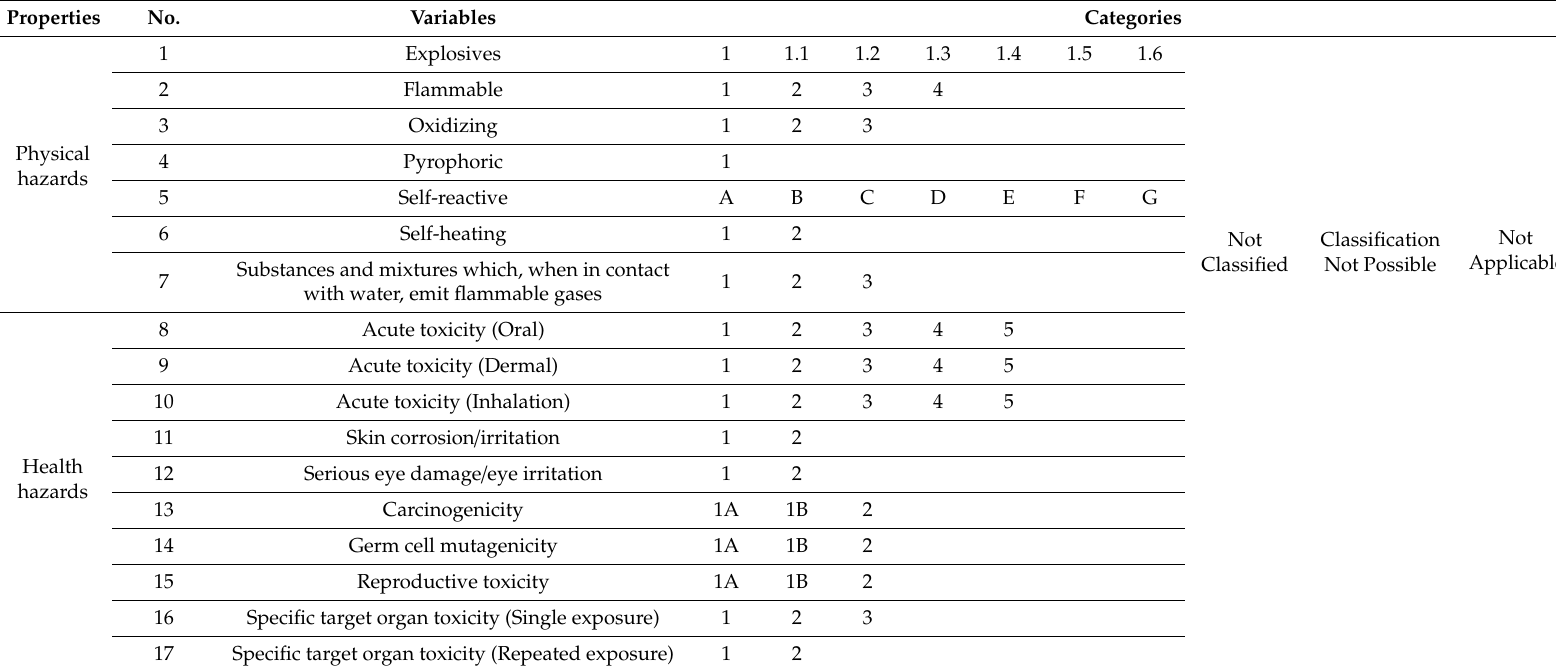
Table 2. Types of physical and health hazard variables according to the Globally Harmonized System